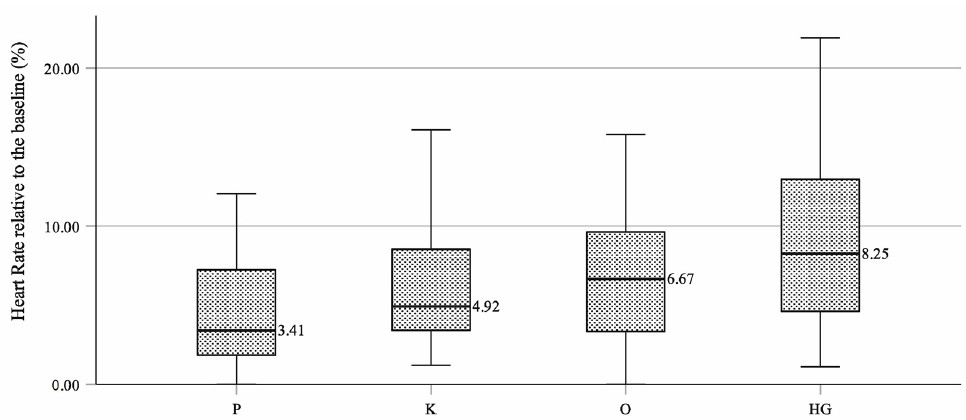
Figure 10. The distribution of heart rate relative to the baseline in % during tasks using each approach for MCI by novice group.